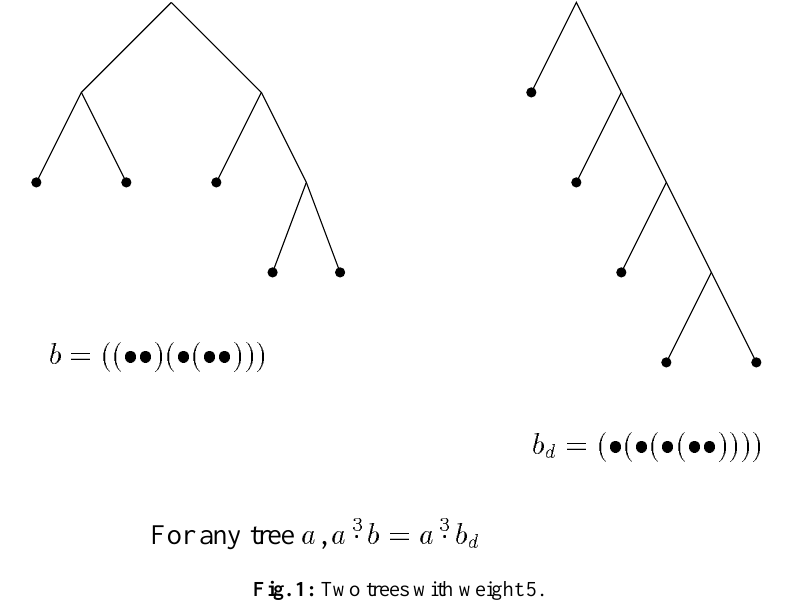
Fig. 1: Two trees with weight